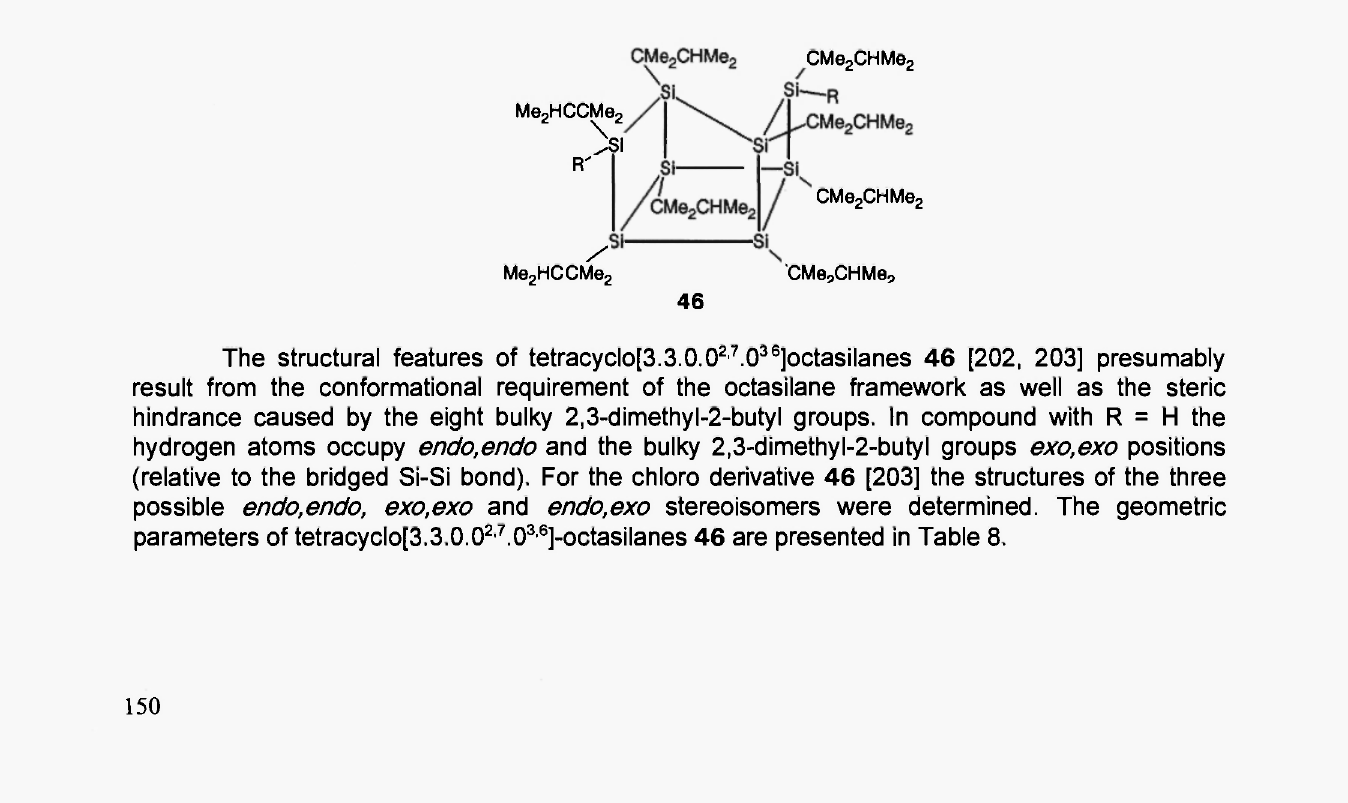
crystallography. In compound 45 two enantiomeric molecules are present in the asymmetric unit with approximately equivalent Si-Si bonds (2.335-2.452 Λ).